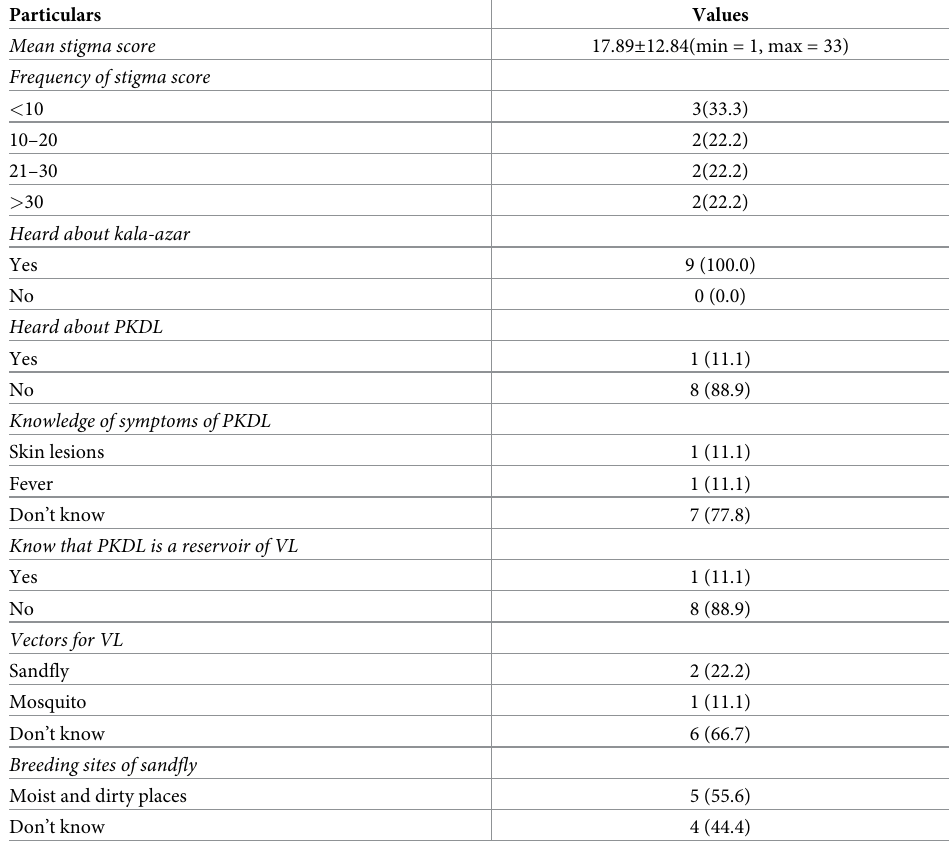
Table 5. Stigma score and knowledge of PKDL patients on VL and PKDL.